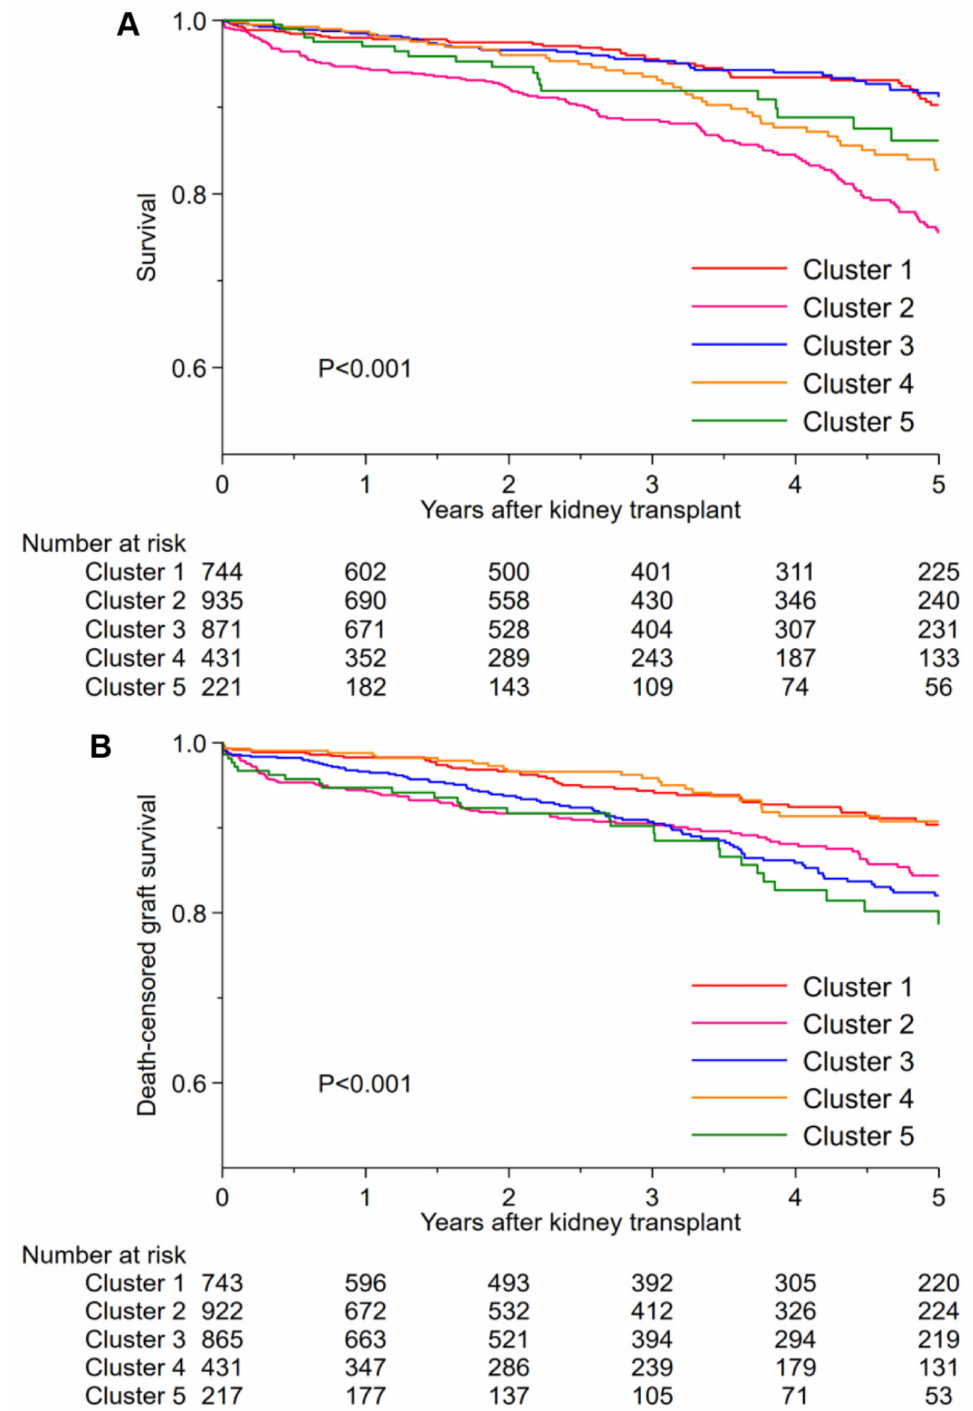
Figure 4. ( A ) Patient survival and ( B ) death-censored graft survival after kidney transplant among five unique clusters of morbidly obese kidney transplant recipients in the